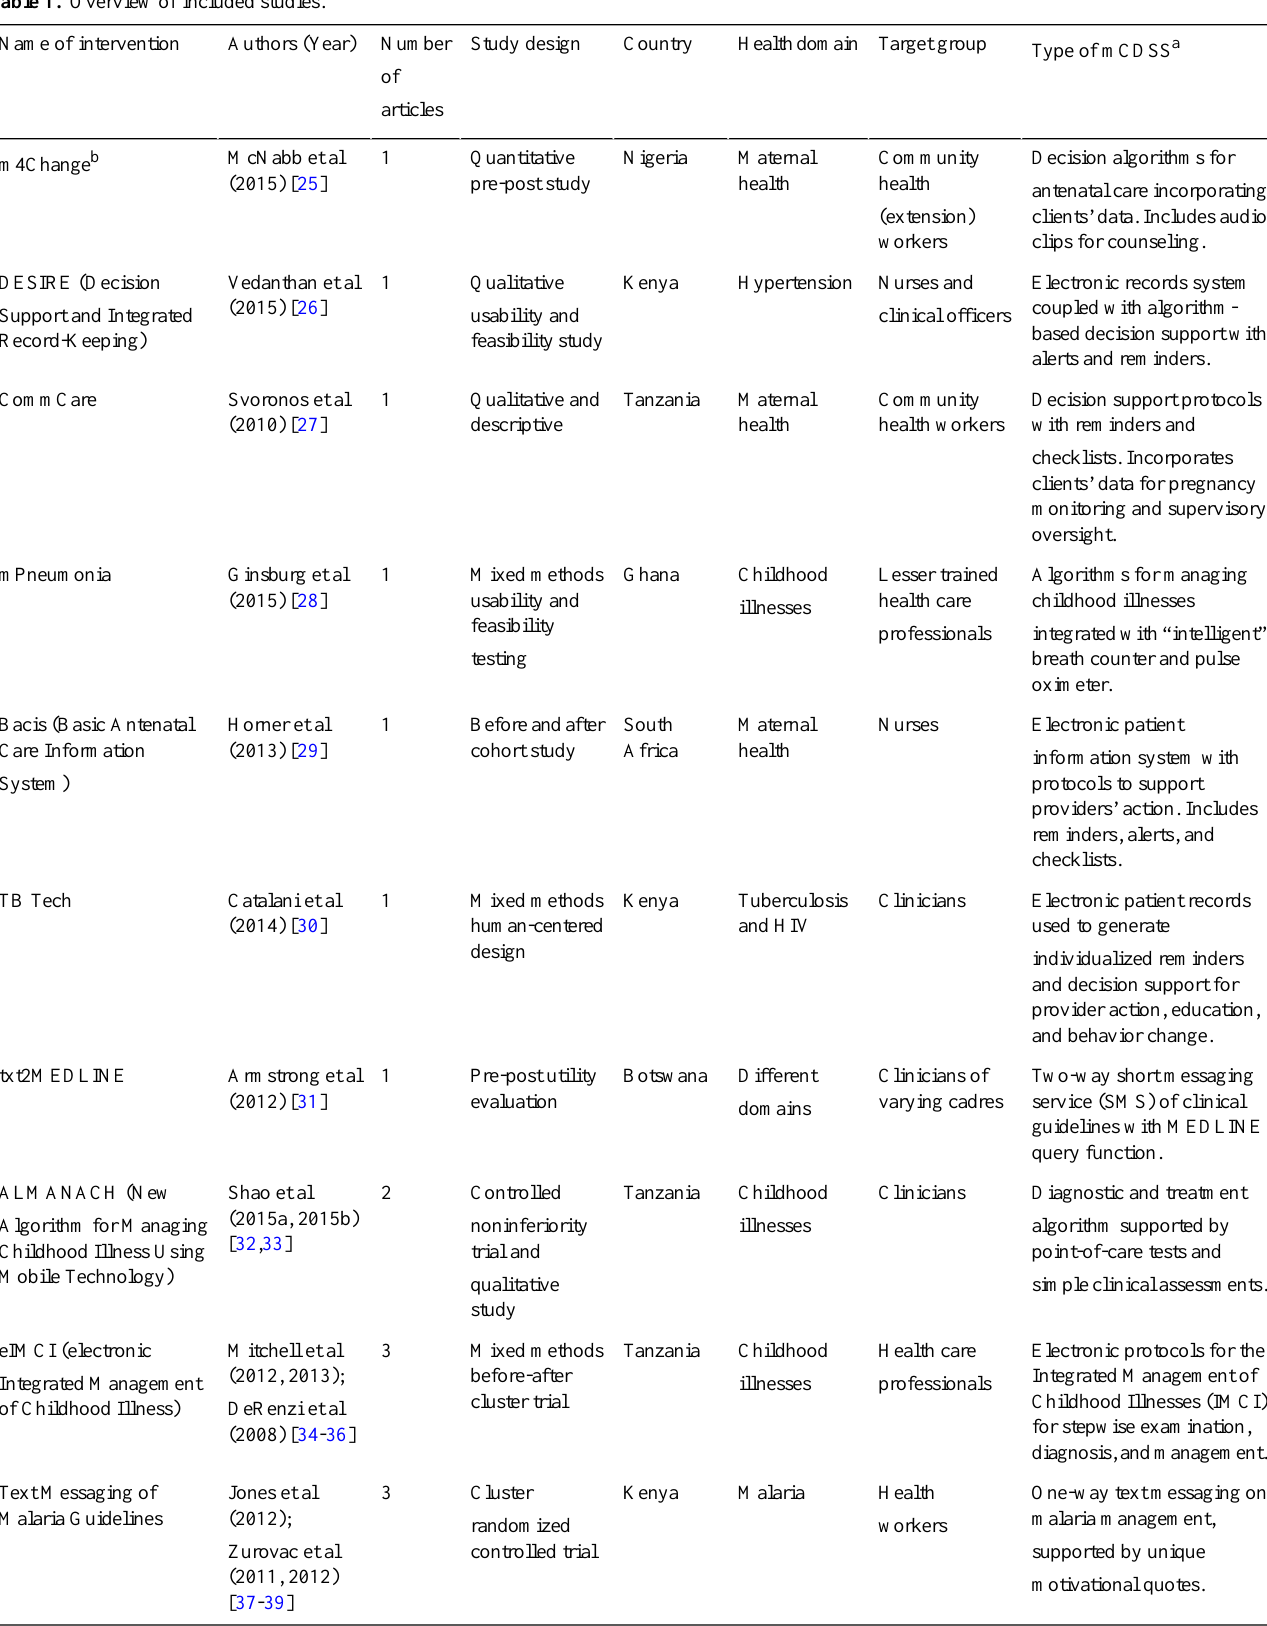
Table 1. Overview of included